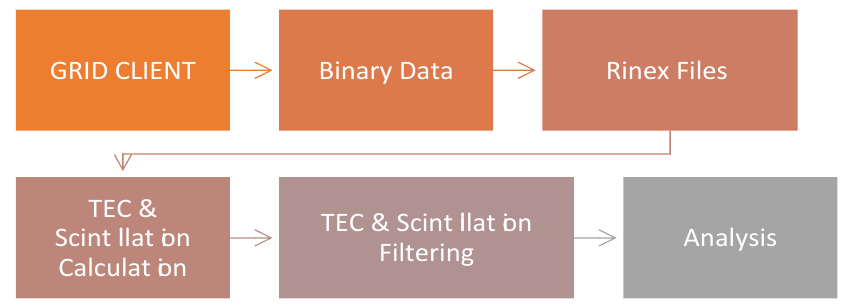
Figure 3. The data processing chart.